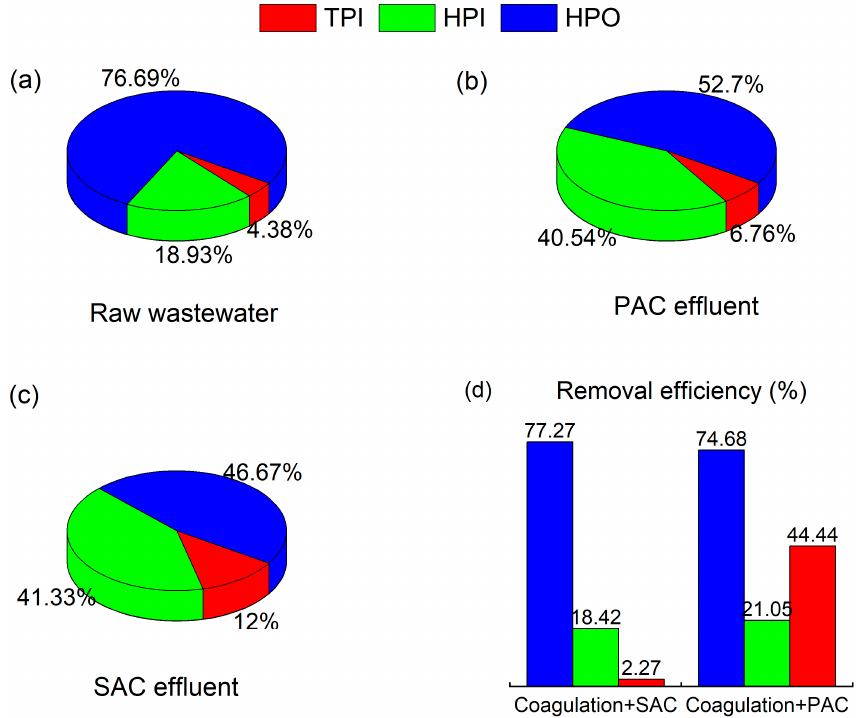
Figure 4. ( a ) Proportion of DOM components in the raw BTCW; ( b , c ) proportion of DOM components after coagulation and PAC treatment; ( d ) removal efficiency of DOM components by coagulation combined and SAC treatment.